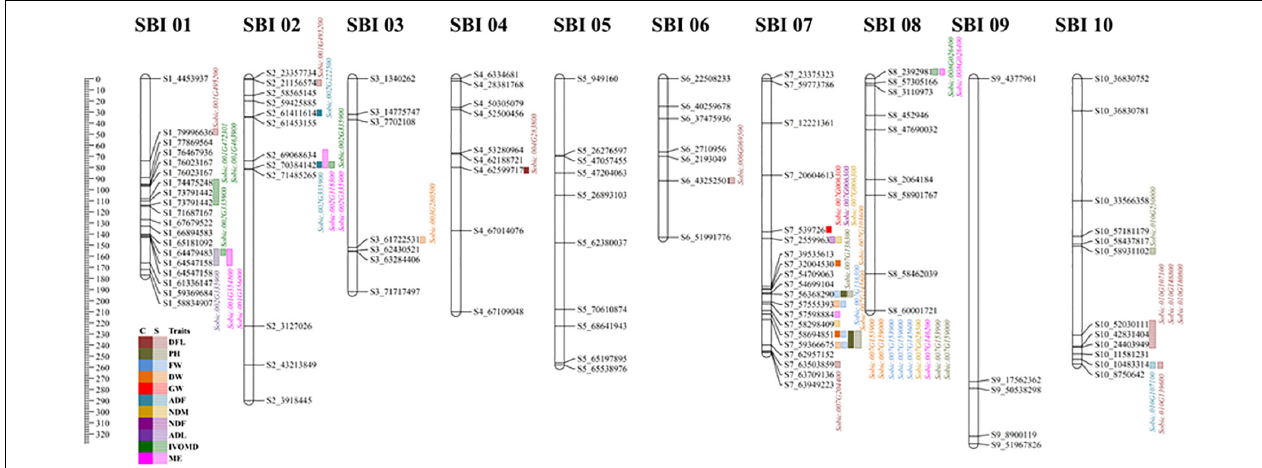
FIGURE 3 | Graphical representation of linkage groups on chromosome for all 11 traits under control and drought treatment for 2 years. The ruler in the left margin has been provided in cm next to the legend for all traits; the traits against which the gene is mapped are color coded; solid color indicates control, and faded color indicates drought. Gene annotation for specific marker was performed using Phytozome